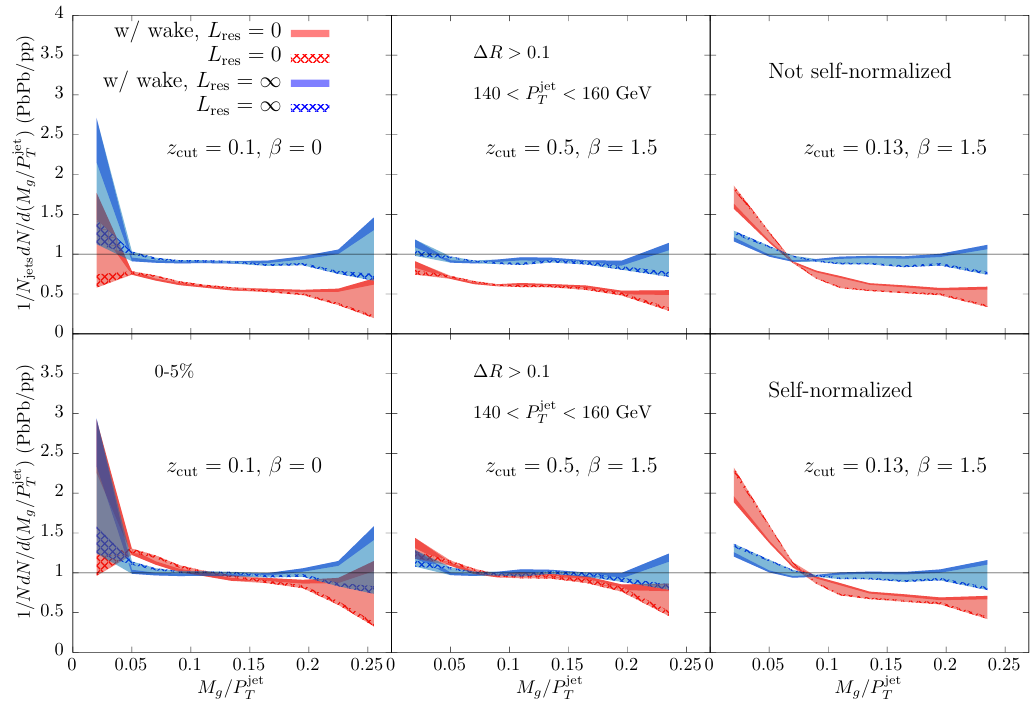
Figure 6 . Ratios of the distribution of M g =p jet in PbPb collisions over that in pp collisions at T p s = 5 : 02 ATeV. (We use p jet rather than the groomed p T;g in the denominator only because T that is what the experimentalists have chosen to present in ref. [67].) In the three top panels, we normalize each PbPb and each pp distribution to the total number of jets found within the cuts in that analysis; in the three bottom panels, we self-normalize each PbPb and each pp distribution. Red (blue) curves correspond to model calculations with a medium that has L res = 0 and can fully resolve the parton shower ( L res = 1 and sees the jet as a single unresolved object). In solid curves we show the full results of our model calculation which include particles coming from the wake in the medium; in dashed curves we show results which don’t include those soft particles. To facilitate the visualization of the contributions of the wake to this observable, we have colored the space between the solid and dashed curves with the same choice of L res . Hence, the width of each colored band shows the e(cid:11)ect of the wake on this observable and the di(cid:11)erence between red and blue shows the e(cid:11)ect of varying L res